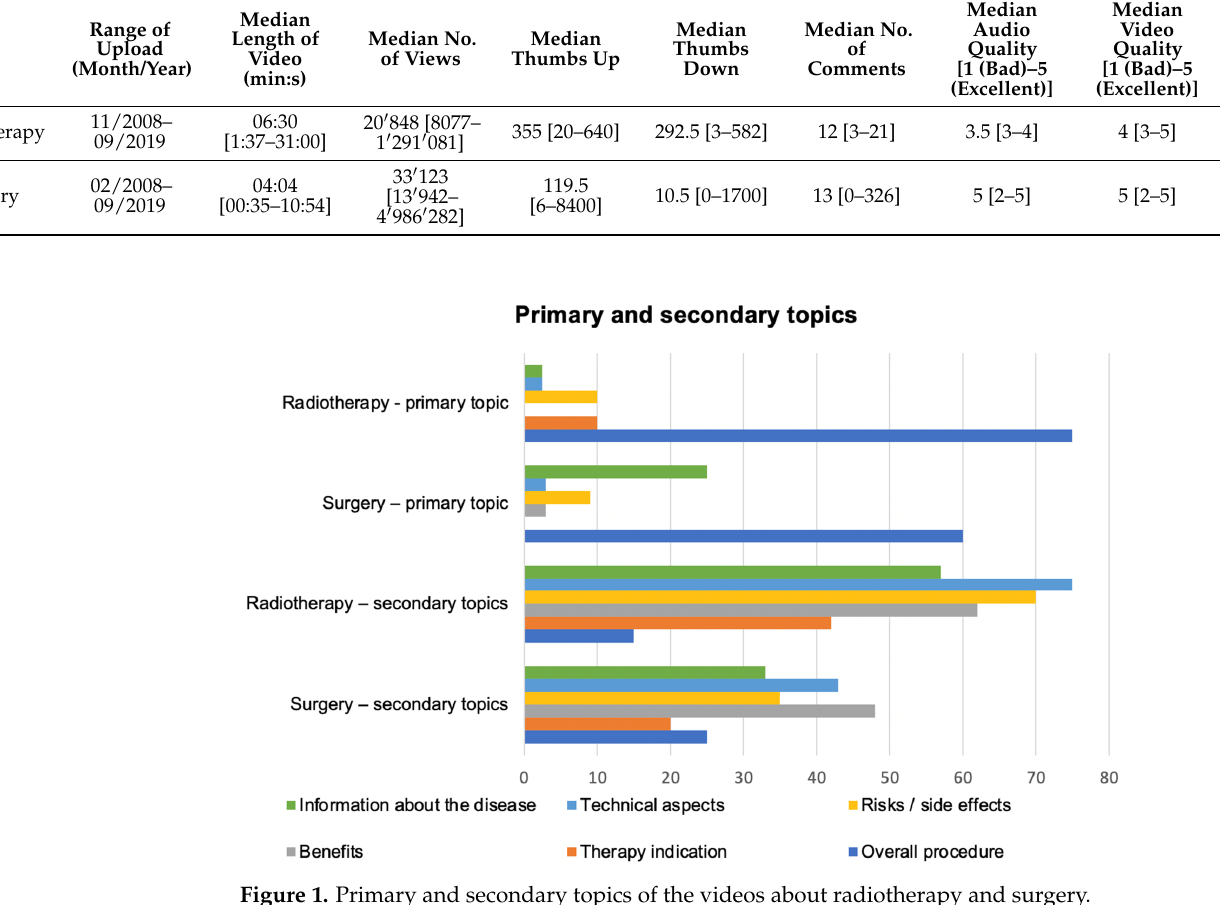
Figure 1. Primary and secondary topics of the videos about radiotherapy and surgery.